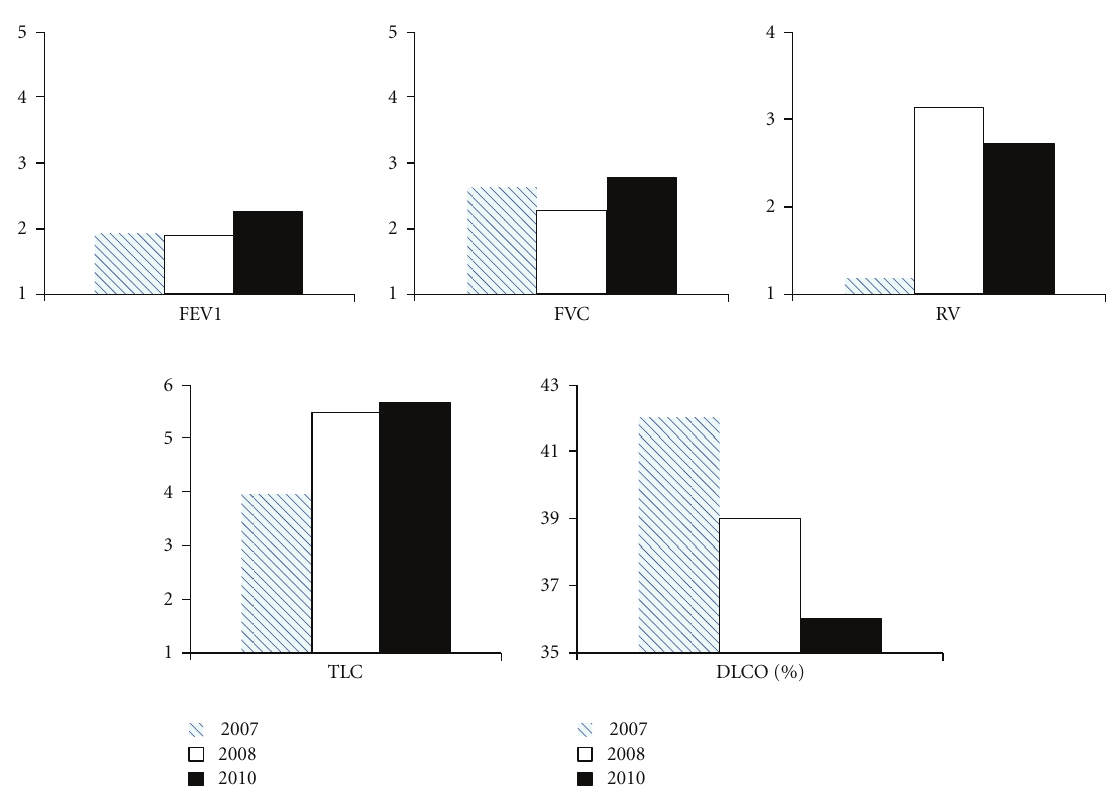
Figure 2: Serial pulmonary function tests from 2007 to 2010 show stable airflow parameters with gradual increase in total lung capacity and residual volume indicating air trapping. Di ff using capacity also progressively decreased consistent with a reduction in gas exchange units as seen in bullous emphysema. Forced expiratory volume at 1sec (FEV1), forced vital capacity (FVC), total lung capacity (TLC), and residual volume (RV) are expressed in liters (L). Di ff using capacity (DLCO) is expressed as percent (%) of predicted.